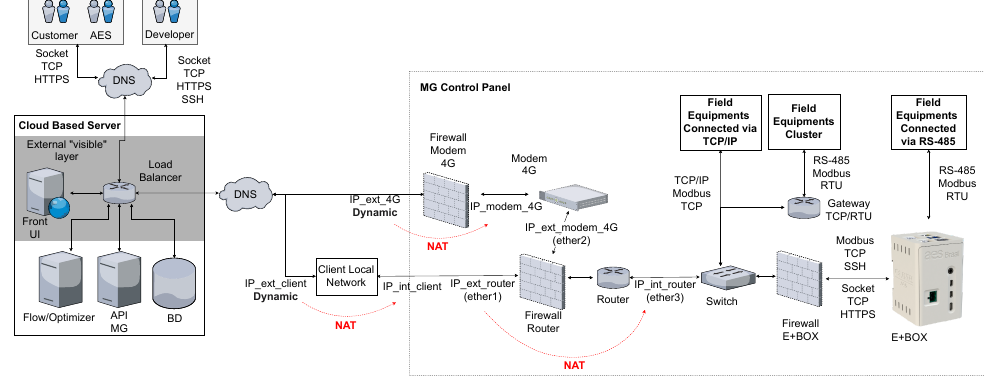
Figure 4. MG network